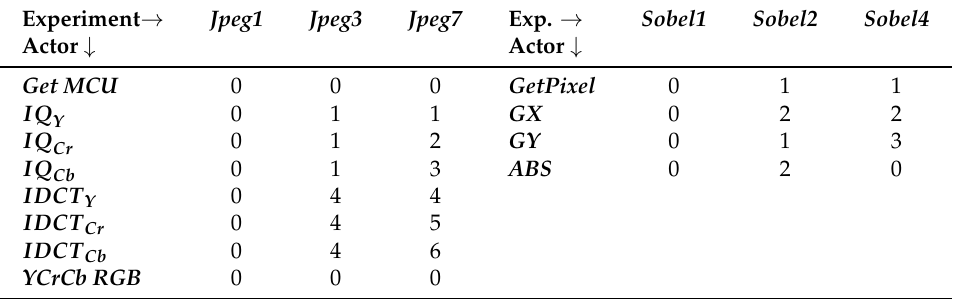
Table 1. Mapping of the Sobel and JPEG experiments on the tiles of the hardware platform. Cp. [2]. Experiment